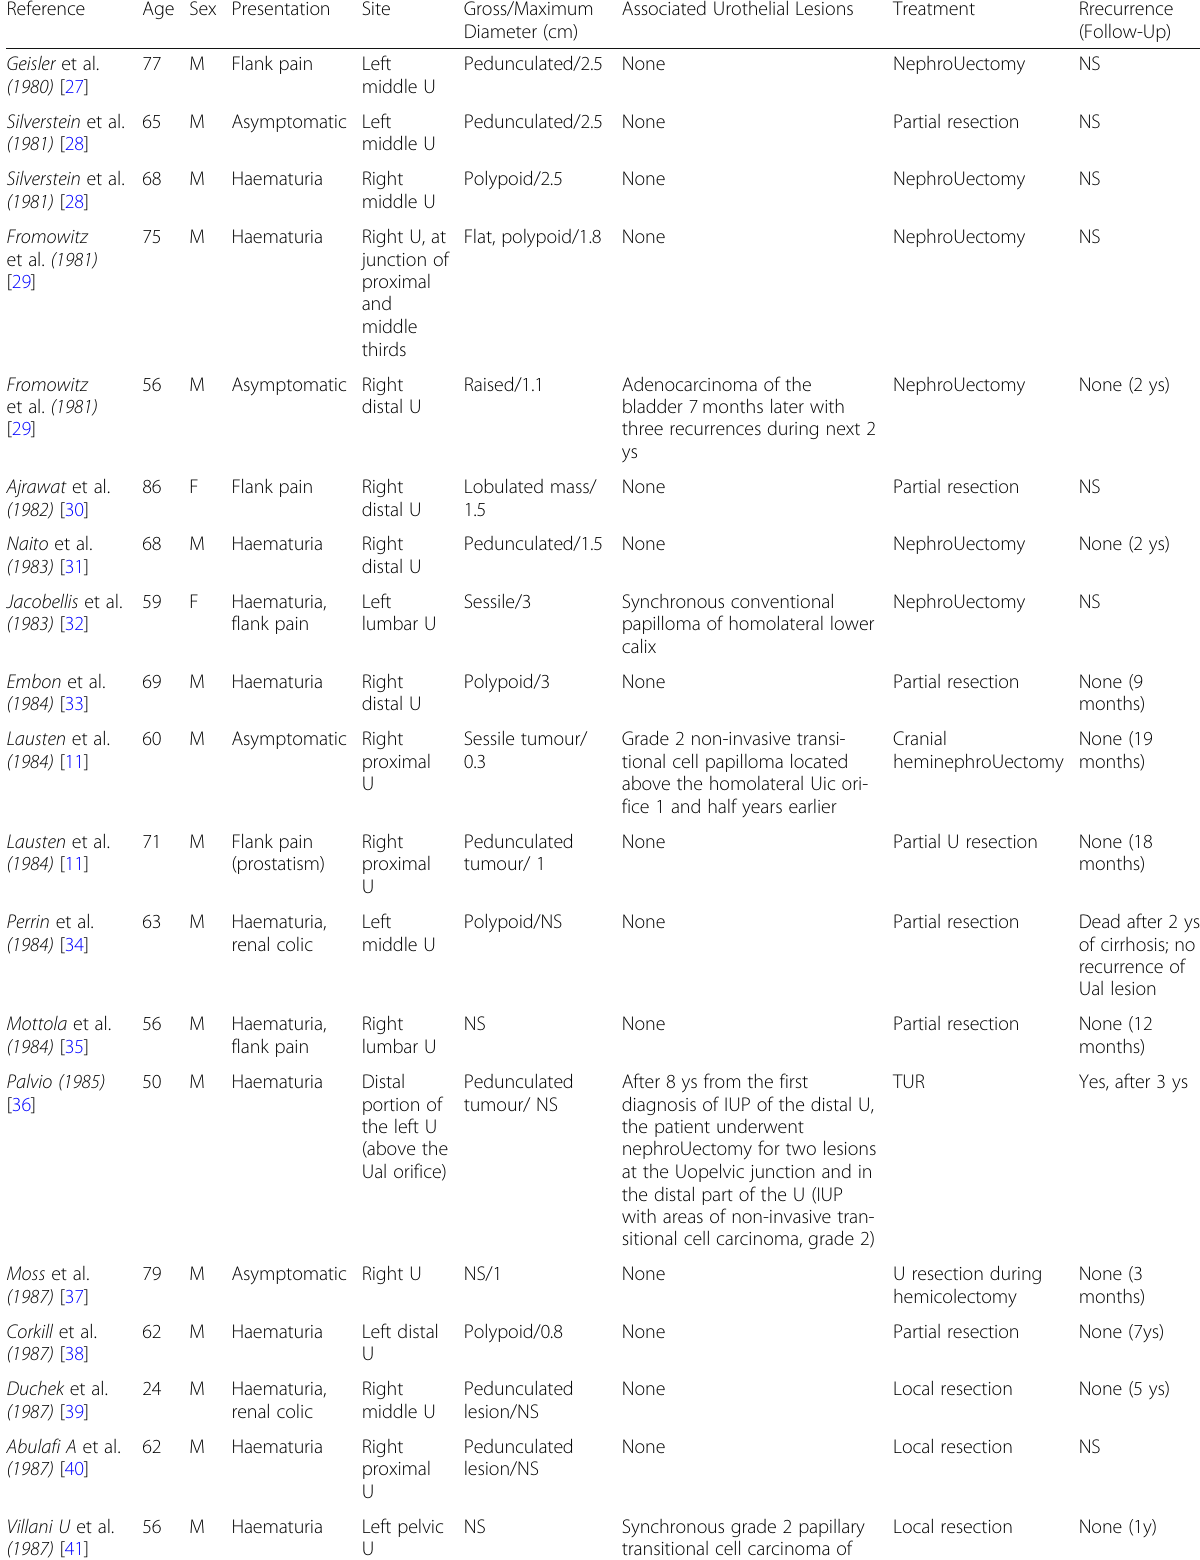
Table 2 IUP of the ureter (U) previously reported in the English Literature (NS = Not Stated; NA = Not Assessed)